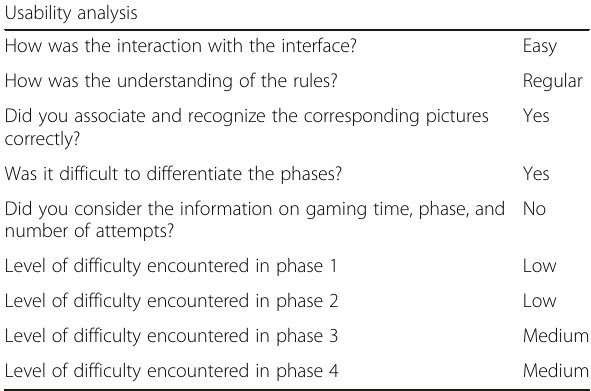
Table 2 Results of the usability analysis Usability analysis